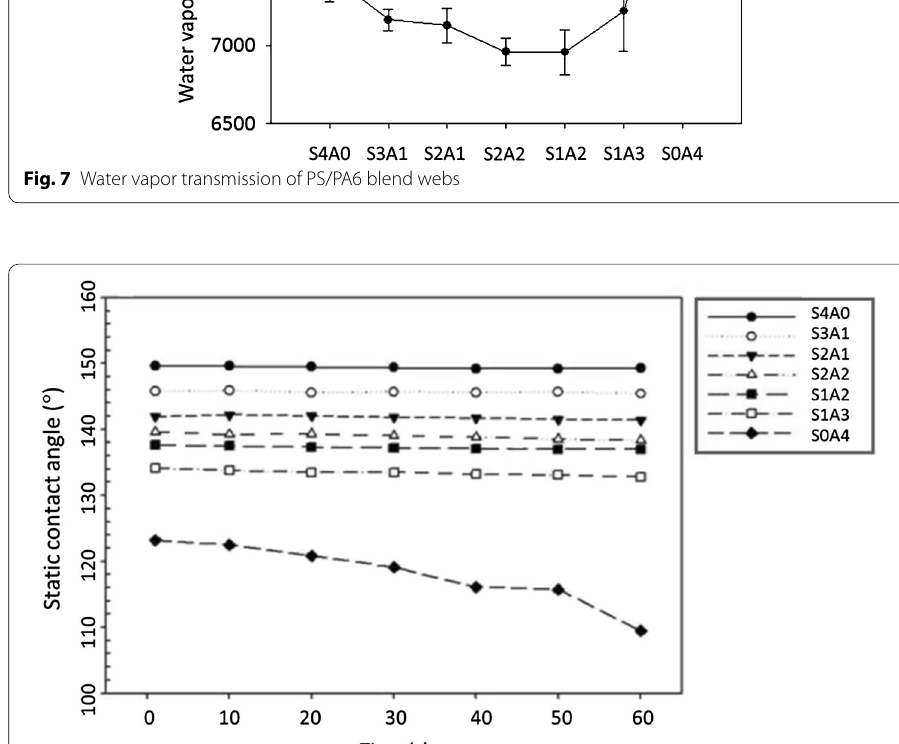
Fig. 8 Static contact angle measurements on PS/PA6 blend